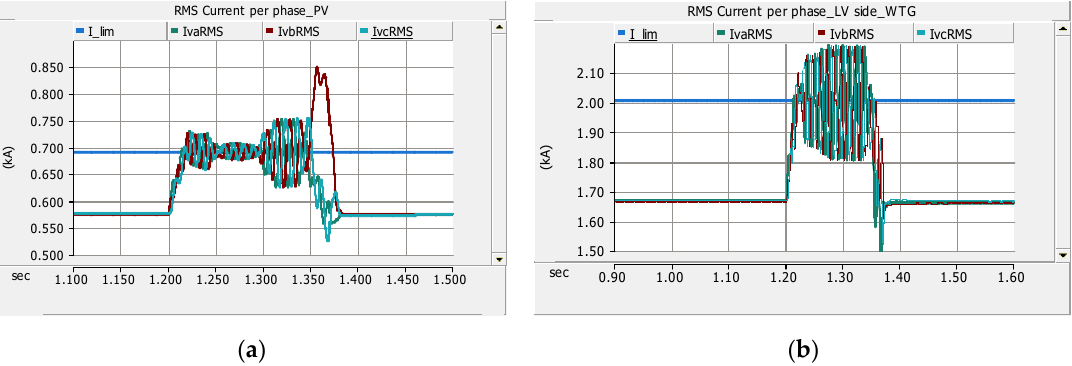
Figure 12. RMS magnitude of current per phase of DGs before, during and after fault F1 (CB2 transfer trip): ( a ) LV side of the PV system and ( b ) LV side of WTG. Note: I_lim is the preset limit of the fault current contribution of DGs.